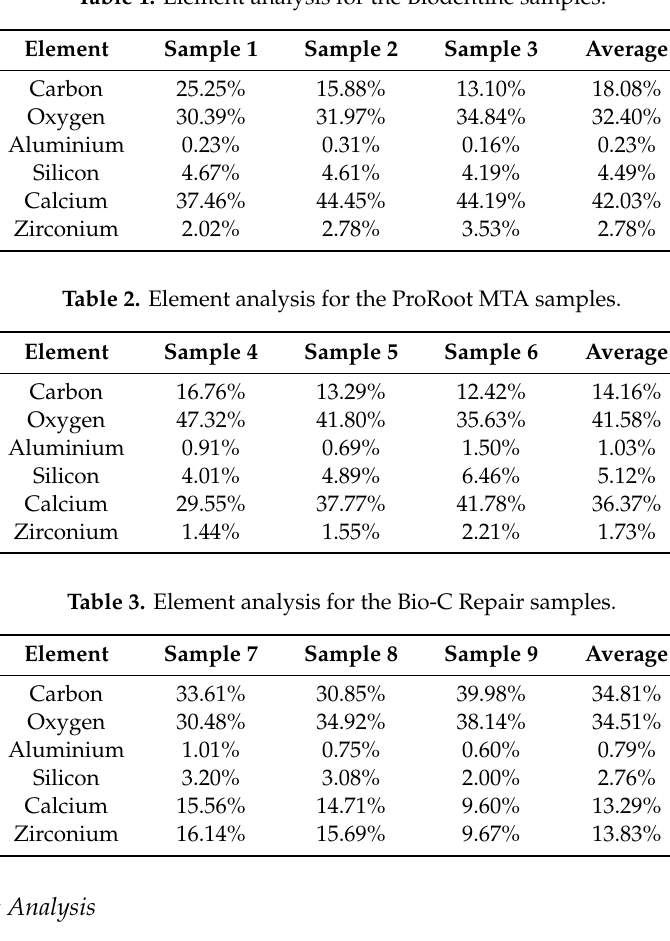
Table 1. Element analysis for the Biodentine samples.